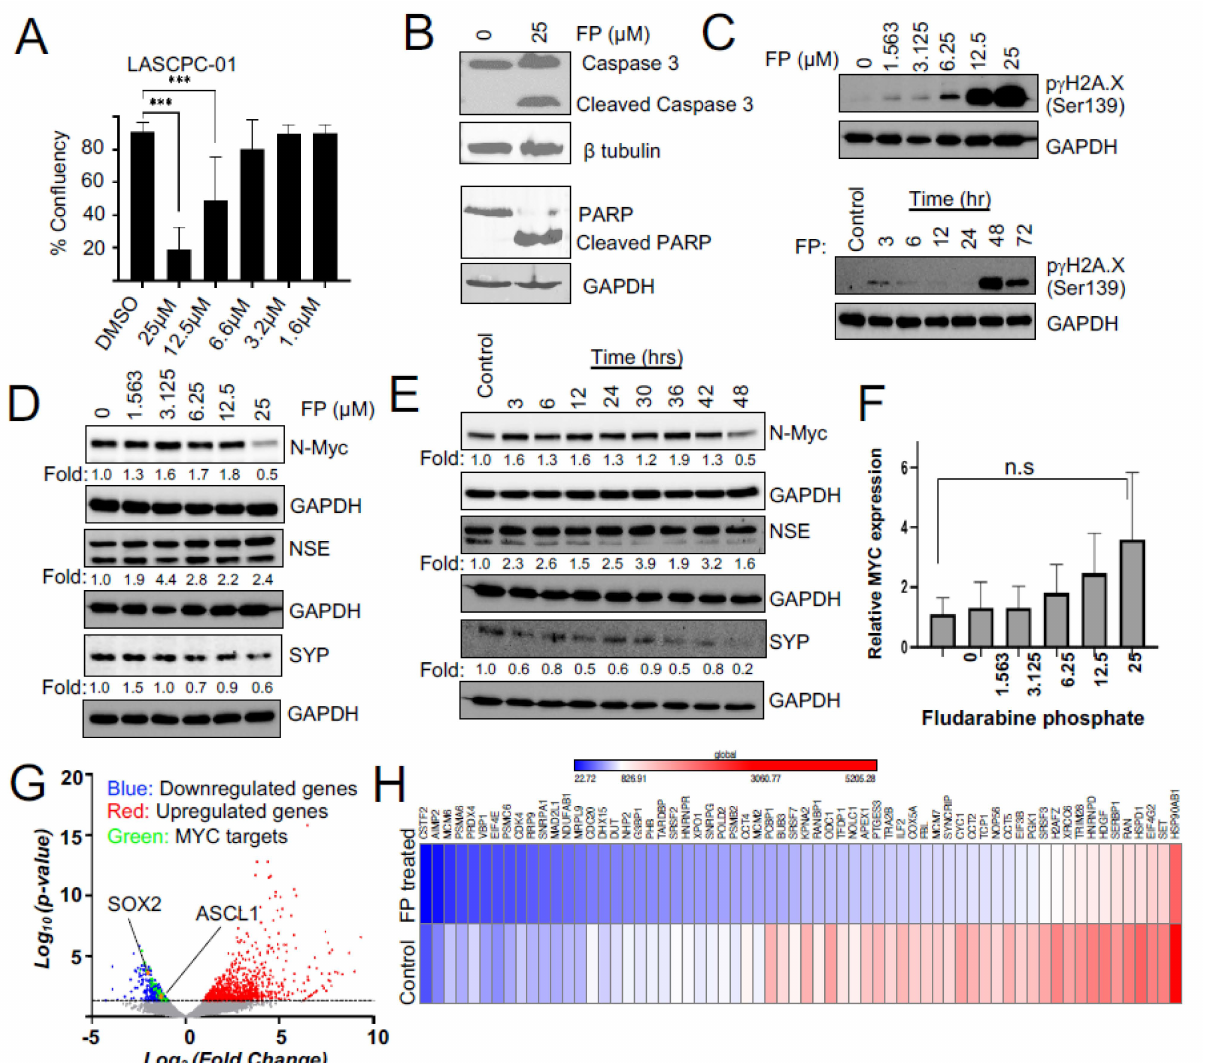
Figure 3. Fludarabine phosphate affects MYC protein levels and MYC transcriptional targets in NEPC cells. ( A ) Confluency measurements of LASCPC-01 cells following treatment of fludarabine phosphate 112 h after seeding (*** p < 0.001). ( B ) Fludarabine phosphate treatment induces